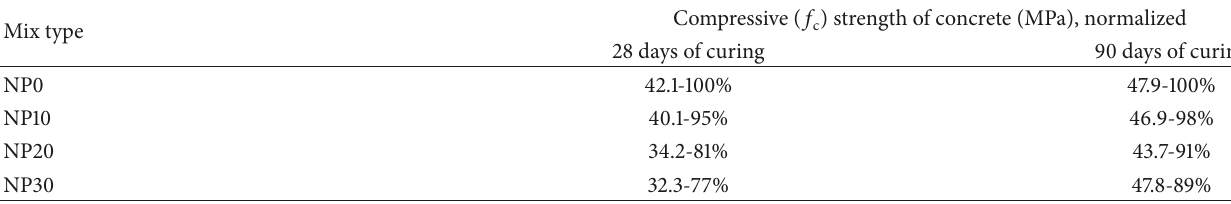
Table 3: Compressive strength development of concrete.